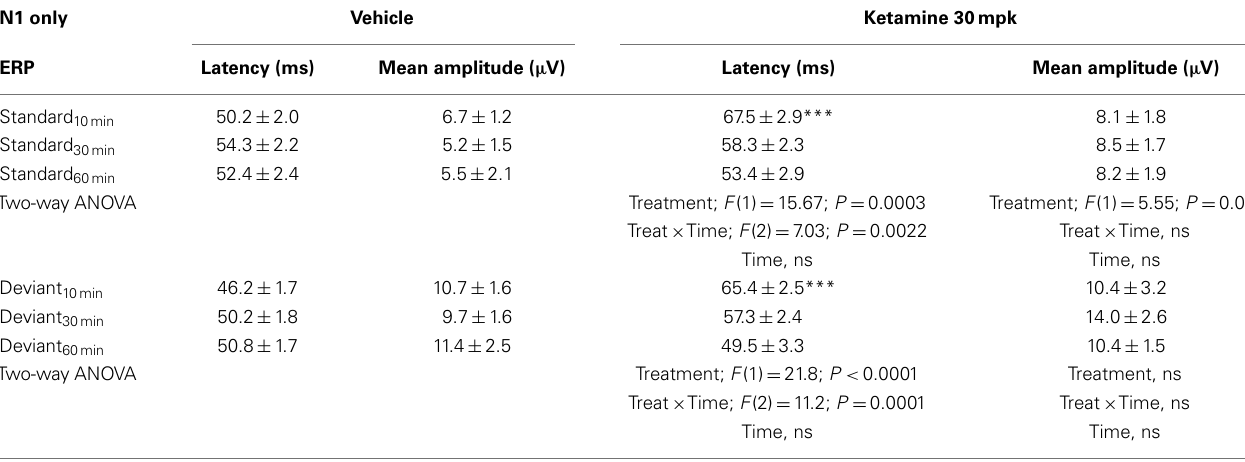
Table 2 | N1 component latency and amplitude tabulated as standard and deviant across vehicle and ketamine treatments